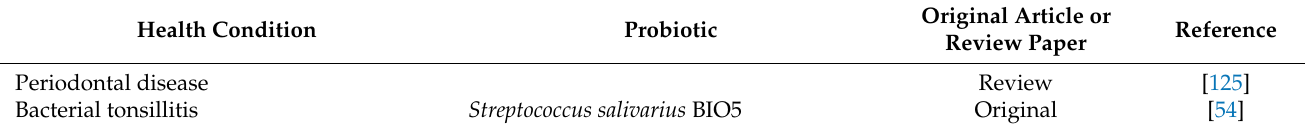
Table 3. Some health benefits for which probiotics, postbiotics, and paraprobiotics have shown a mixed to favorable result in an original study or in a meta-analysis. Due to the difficulty of being consistent involved in evaluating the strength of the evidence for the effectiveness of probiotics